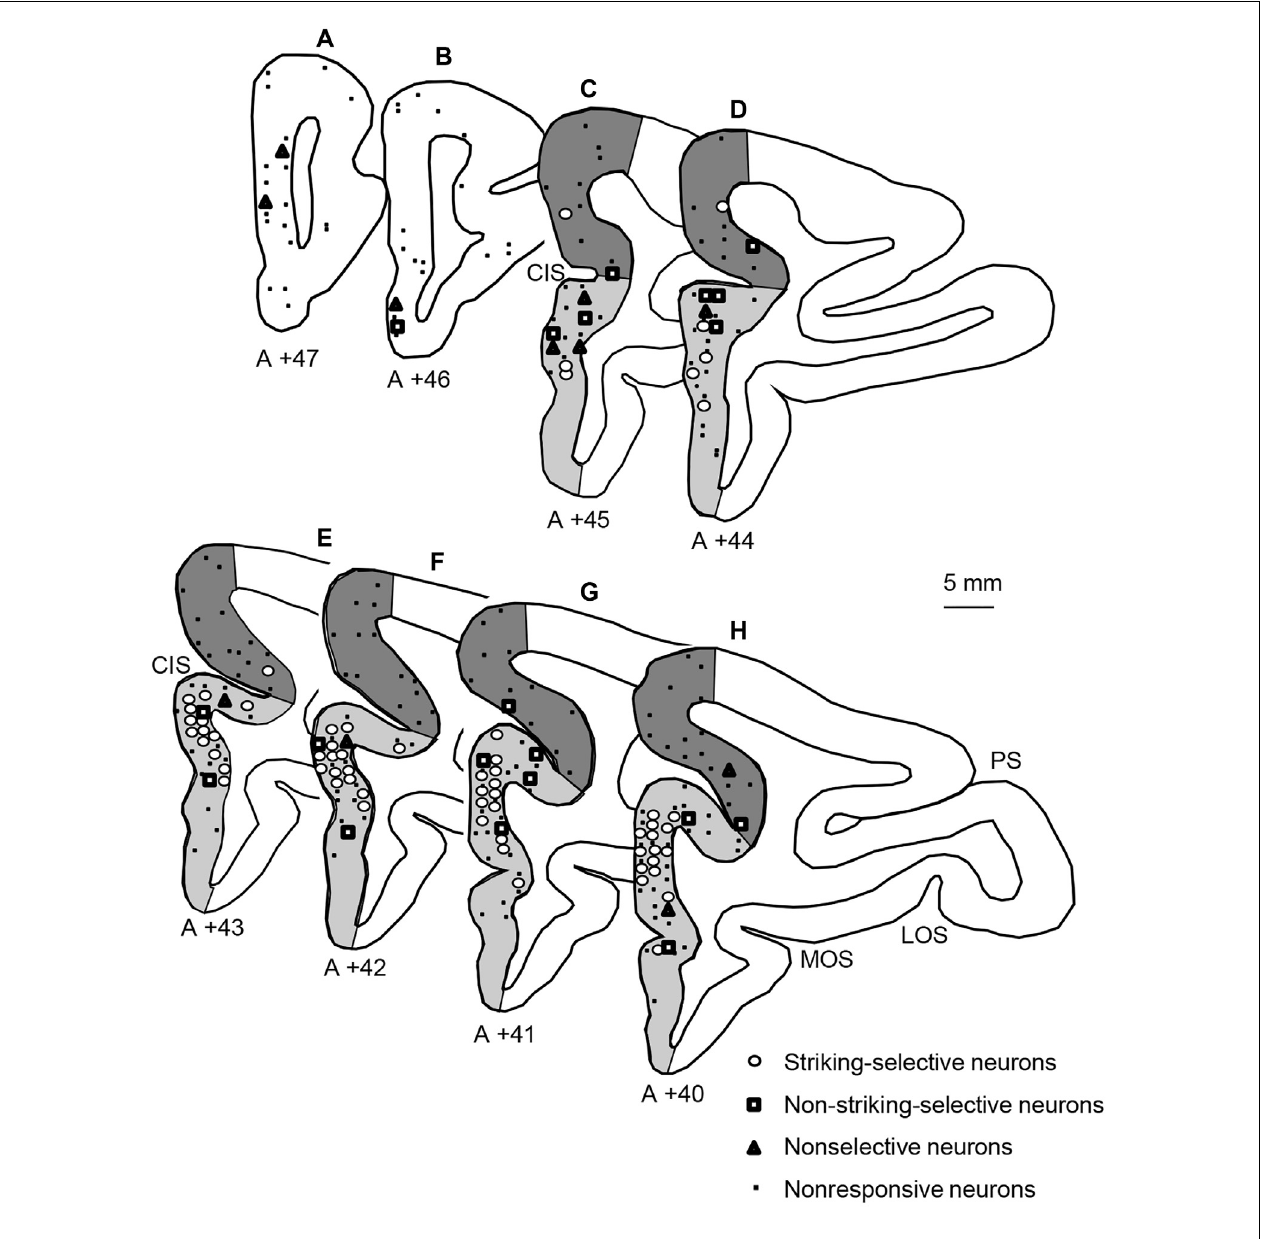
FIGURE 5 | Locations of the three types of snake-responsive neurons in the mPFC. (A–H) Locations of mPFC neurons plotted in coronal sections at different A-P levels. The number under each section, distance (mm) anteriorly from the interaural line. Open circles, striking-selective neurons ( n = 64); open squares, non-striking-selective neurons ( n = 20); open triangles, nonselective neurons ( n = 11); dots, nonresponsive neurons ( n = 140). The mPFC was divided into three subareas: an anterior part of the mPFC (white areas in A,B ), a dorsal part of the mPFC (dark gray areas in C–H ), and a ventral part of the mPFC (light gray areas